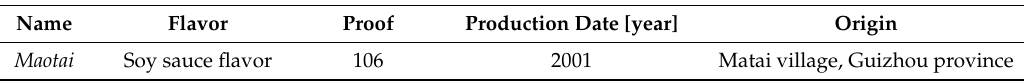
Table 3. The parameters of Maotai (the most famous Chinese liquor).